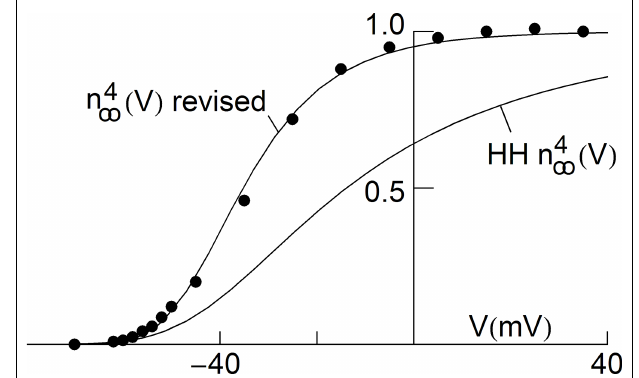
activation by GHK (fi lled circles). K + β /( α )) 4 n n n = 0.125 n